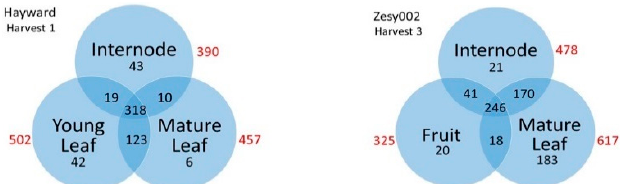
Figure 1. Venn diagrams showing the distribution of metabolites among different tissues of ‘Hay- ward’ (Harvest 1) and ‘Zesy002’ (Harvest 3) kiwifruit vines. Data are presented for 583 and 699 metabolites having greater than 80% and 100% detection thresholds in Hayward and ‘Zesy002’ kiwifruit respectively as measured in bulked QC samples. Red numbers are the total number of metabolites detected in that tissue.